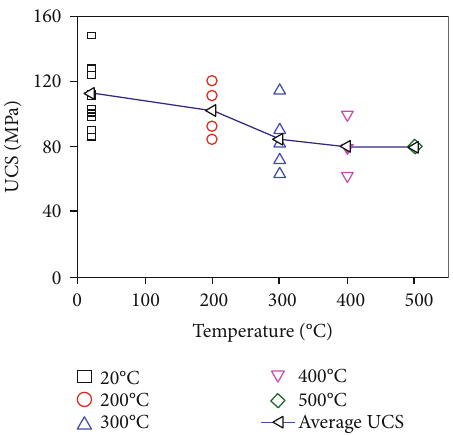
Figure 5: Uniaxial compressive strength of the granite samples vs. temperature.